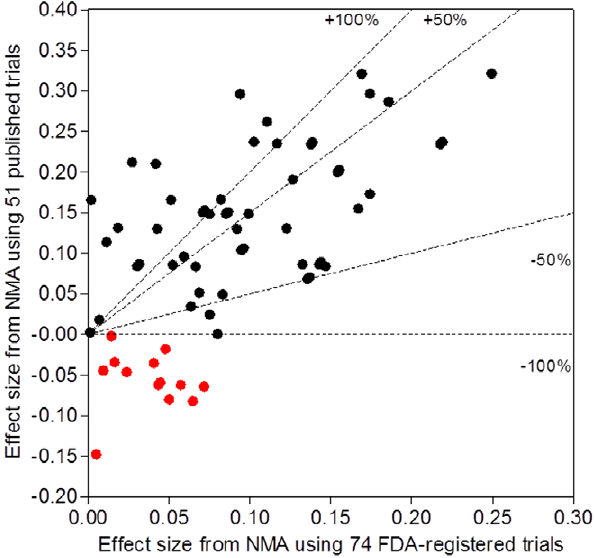
Figure 2. Scatterplot of estimates of relative efficacy for 66 pair-wise comparisons of the 12 antidepressant agents with one another derived from network meta-analyses of data from 74 FDA-registered trials and their 51 trial publications. Data are effect sizes. Positive effect sizes indicate that drug A has higher efficacy than drug B. The two areas above the uppermost dotted line (labeled + 100%) and below the lowest dotted line (labeled 2 100%) correspond to cases in which an effect size derived from the network meta-analysis of the 51 published trials differed in absolute value from that derived from the network meta-analysis of the 74 FDA-registered trials by at least 100%. The two areas between the 2 upper dotted lines (labeled + 50%) and between the 2 lower dotted lines (labeled 2 50%) correspond to cases in which an effect size derived from the network meta-analysis of the 51 published trials differed in absolute value from that derived from the network meta-analysis of the 74 FDA-registered trials by at least 50%. Red-colored points refer to cases in which agent B was superior to agent A by one network meta-analysis and A was superior to B by the other network meta-analysis.